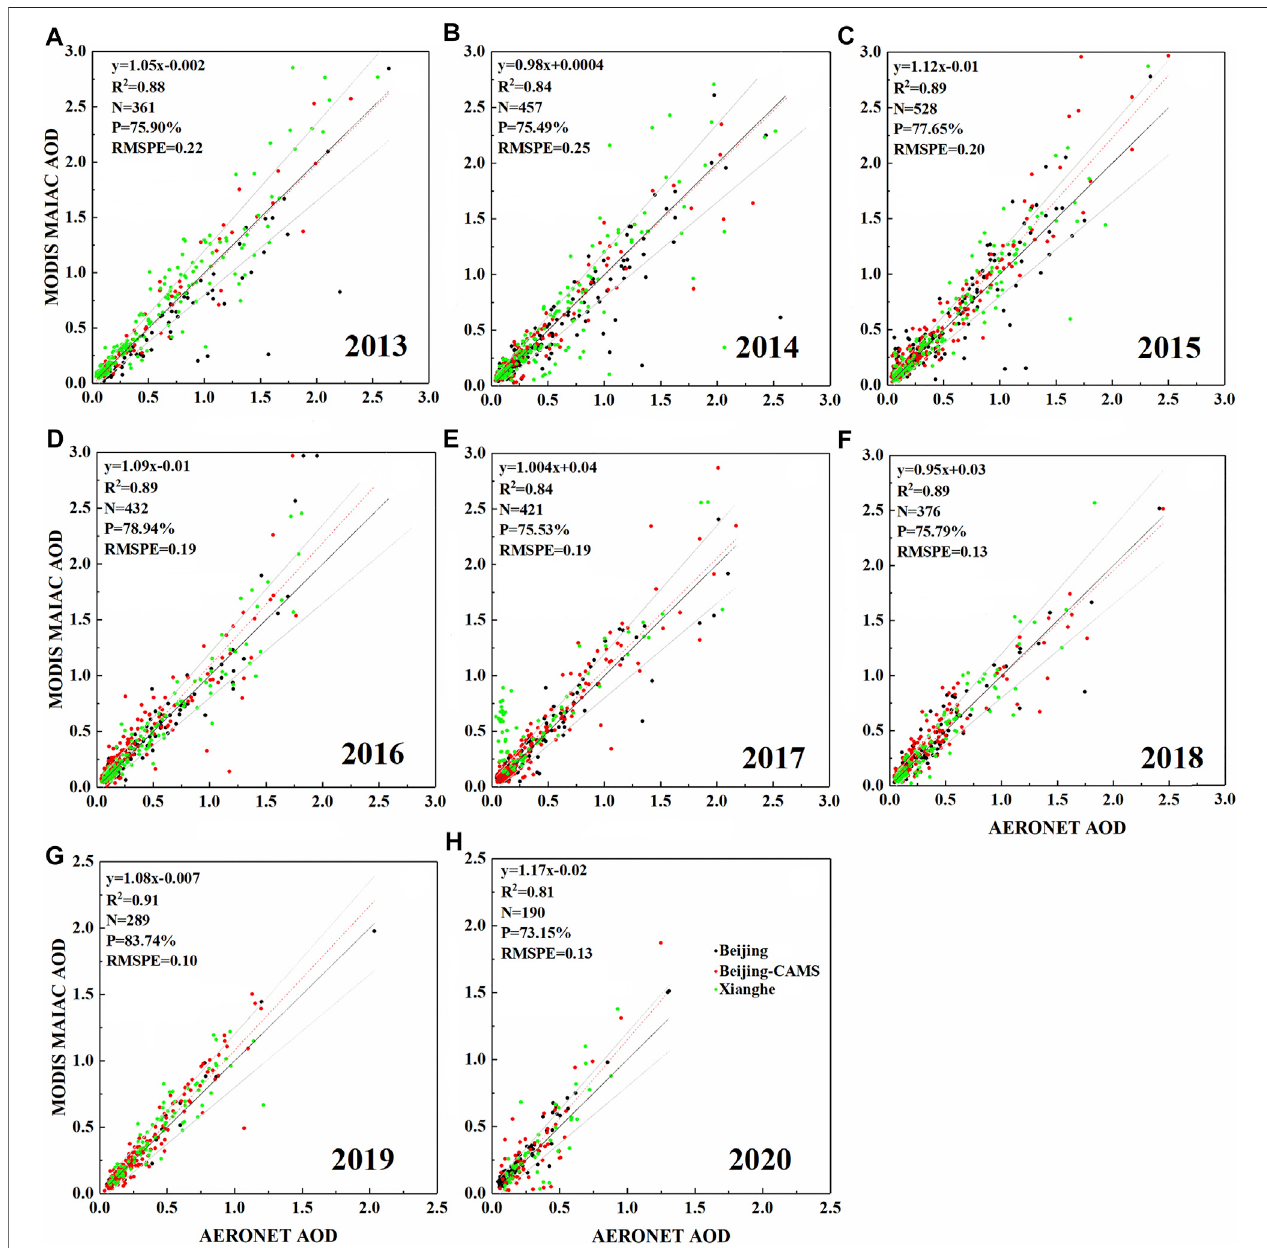
FIGURE 2 | Scatter plot of MODIS MAIAC AOD and AERONET AOD at 550 nm for the period of 2013 – 2020 (A – H) . The red dashed line is the regression line. The blacklineisa1:1line.Thegraylinesrepresenttheexpectederror(EE)envelopes[±(0.05+20%×AERONETAOD)].Italsoshowsthecoef fi cientofdetermination( R 2 ),the number of samples (N), the percentage in EE (P), and the root mean square prediction error ( RMSPE ).